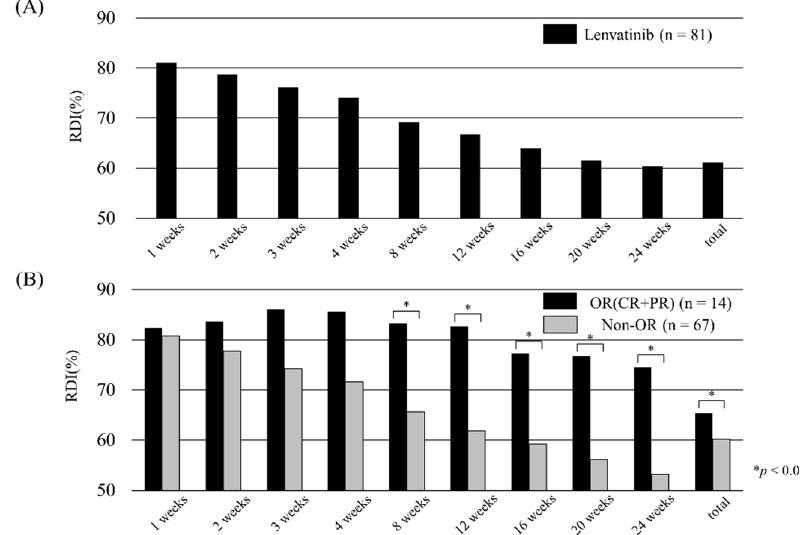
Figure 3. Relative dose intensity (RDI) of lenvatinib ( A ) for all patients and ( B ) stratified by radiological response. (A) RDI for each week. The overall RDI was 61.1%. (B) RDI for each week stratified by objective response (OR; black bars) and non-OR (gray bars). After 8 weeks, the OR group tended to have a significantly higher RDI ( p < 0.05).